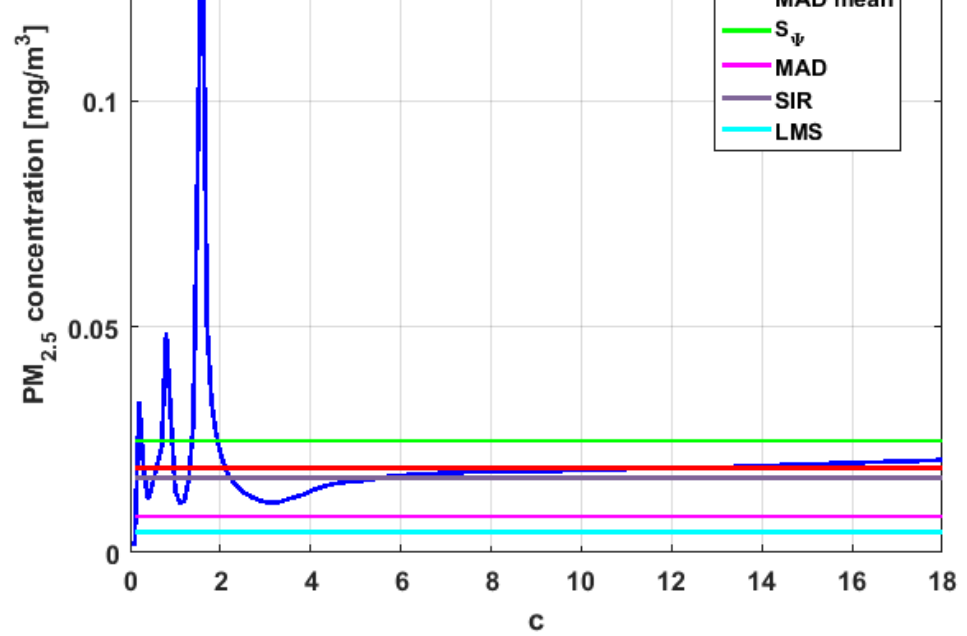
Figure 26. 𝑆 𝑏𝑖 estimates of 𝑌 1 . Figure 26. S bi estimates of Y 1 .